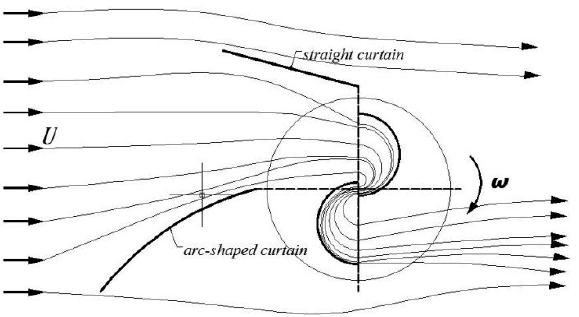
Figure 2. Working principle of the straight–arc curtain.